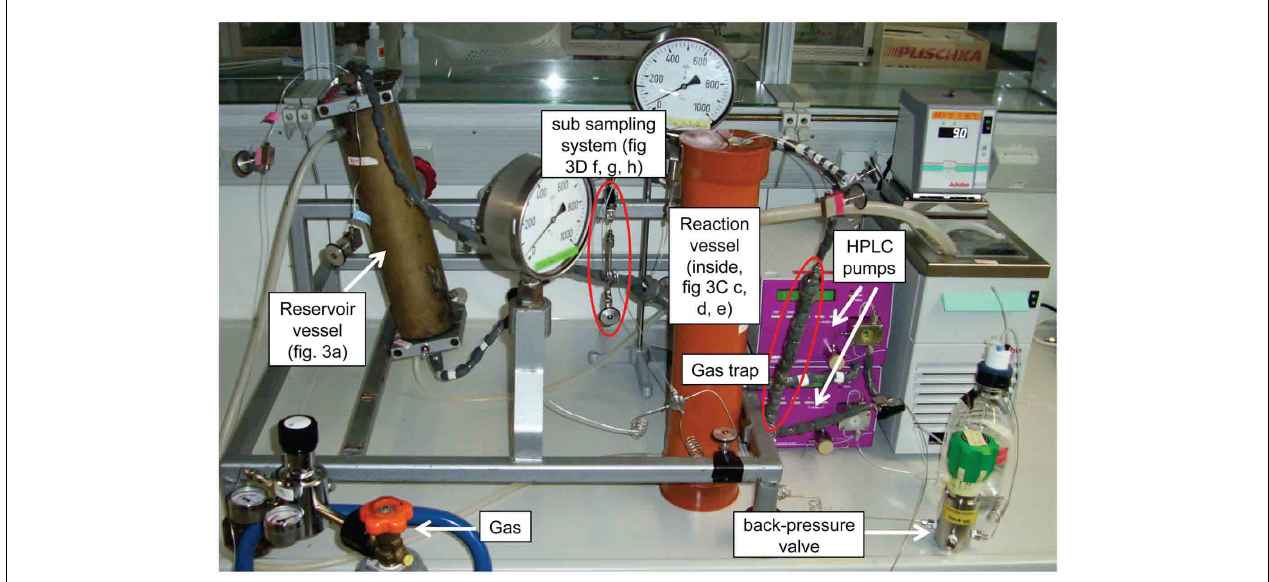
FIGURE 2 | Photograph of the high-pressure incubation system as seen in Figure 1. Reservoir vessel, reaction vessel, incubator, and sub-sampling device are shown in detail in Figure 3